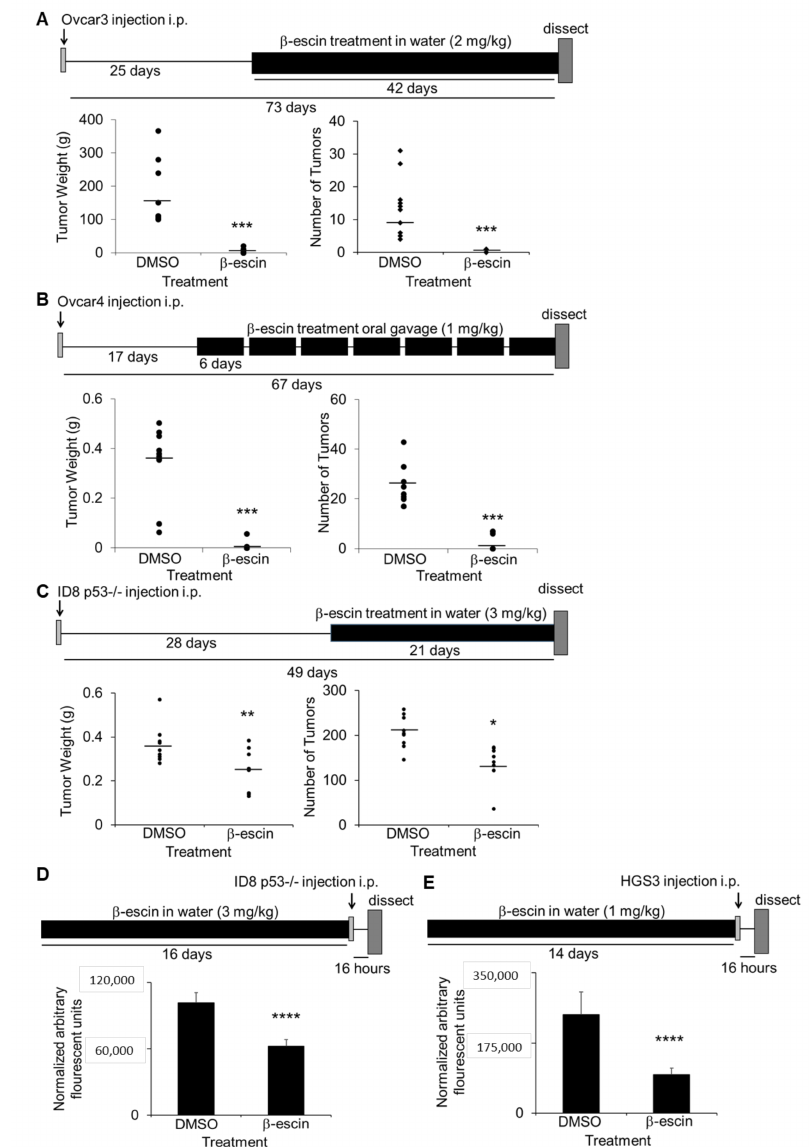
Figure 5. β -escin inhibits ovarian cancer metastasis in vivo. ( A – C ) In vivo intervention metastasis assays. The total tumor weight and the number was determined (circles: individual mouse results; line: mean). *, p < 0.05; **, p < 0.01; ****, p < 0.001. ( A ) Twenty-five days after the intraperitoneal injection of Ovcar3 cells (4 million), athymic nude mice were given water ad libitum with β -escin (2 mg/kg/day) or DMSO (50 µ L equal volume) in 500 mL total volume, and was sacrificed 42 days later. ( B ) Seventeen days after intraperitoneal injection of Ovcar4 cells (4 million), athymic nude mice were treated six days a week by oral gavage with β -escin (1 mg/kg/day) or DMSO (1 µ L equal volume) in PBS (100 µ L total) and sacrificed 50 days later. ( C ) Twenty-eight days after intraperitoneal injection of ID8 p53-/- (5 million), mouse ovarian cancer cells, C57Bl/6 mice were given water ad libitum with β -escin (3 mg/kg/day) or DMSO (50 µ L equal volume) in 500 mL of total volume, and sacrificed 21 days later. ( D,E ) In vivo prevention assay for adhesion/invasion. Fourteen days after the C57BL/6 mice were given water ad libitum with β -escin (1 mg/kg/day) or DMSO (50 µ L equal ID8 p53-/- cells (5 million) ( D ) or CMFDA-labeled HGS3 cells (5 million) ( E ) of mouse ovarian cancer cells. The mice were sacrificed 16 h post cancer cell injection and the luciferase signal ( D ) or the fluorescence signal ( E ) in the omentum was measured (mean ± SD). ****, p <